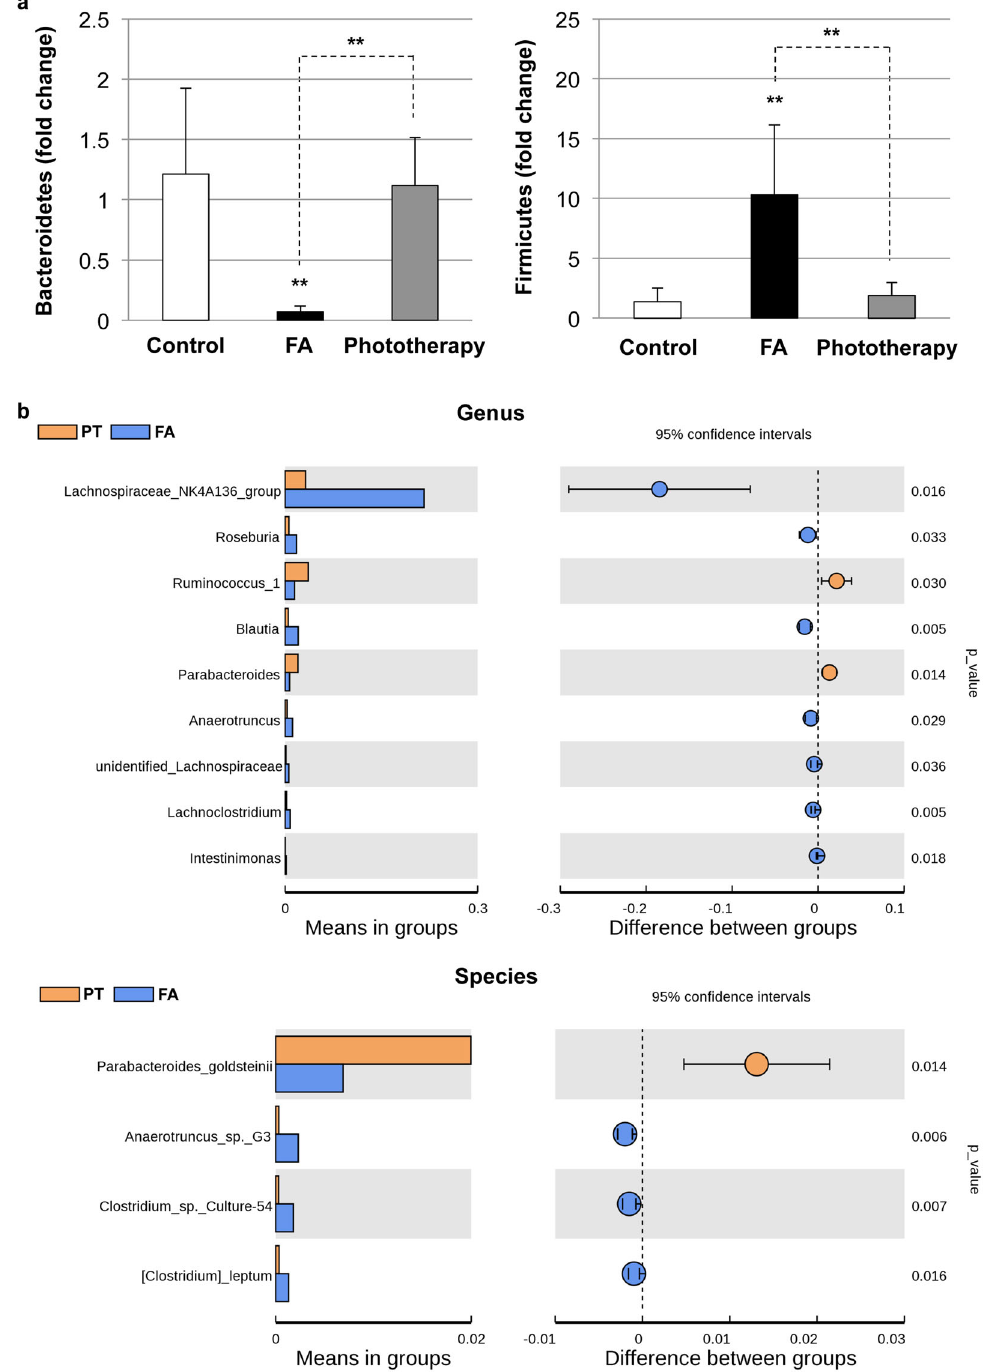
Fig. 6 Altered fecal microbiota composition in food allergy (FA). a Quantitative real-time PCR for veri fi cation of the phyla Bacteroidetes and Firmicutes . Values are presented as the mean ± SD of at least eight individuals in each group. ** P < 0.01 vs. the control or phototherapy group (Student ’ s t test). b Beta diversity comparison of gut microbiomes between the FA and phototherapy groups. The data indicate the abundance of species and the difference between groups (95% con fi dential interval) at the genus and species levels. FA food allergy, PT line with our current data, a recent study demonstrated the existence of a link between vitamin D 3 de fi ciency and altered gut microbiota composition characterized by the reduction in the phylum Bacteroidetes and the elevation of the phylum Firmicutes 41 .